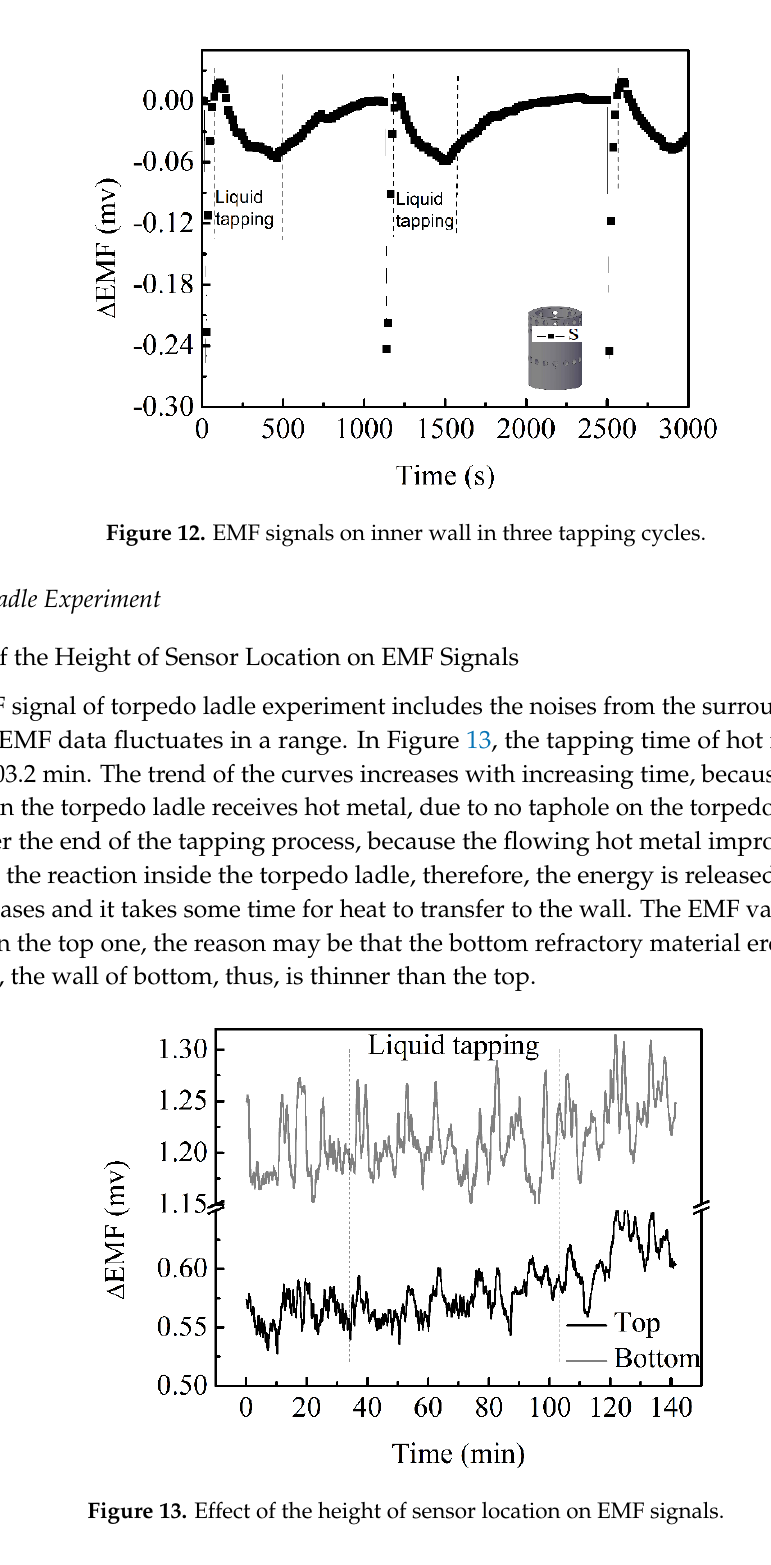
Figure 14. EMF signals at different depth in the same location. 5. Conclusions This article tries to apply the EMF on monitoring liquid level of a laboratory scale of blast furnace hearth using a single layer of water and double layer of water and oil, laboratory experiment results, then, are convinced by torpedo ladle experiment. Based on the results of laboratory experiment and torpedo ladle experiment, the following conclusions can be highlighted. (1) The liquid level has the same trend as the EMF signal in the tapping process and the EMF signal can characterize the liquid level, which indicates that the EMF signal can characterize the liquid level in the hearth of the blast furnace. The EMF signals are both different in height and in the